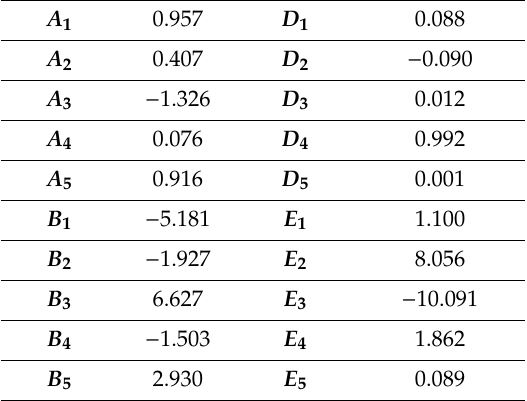
Table 4. Calculated coe ffi cients for the “Curve Fit Method” for the water-to-water HP. A